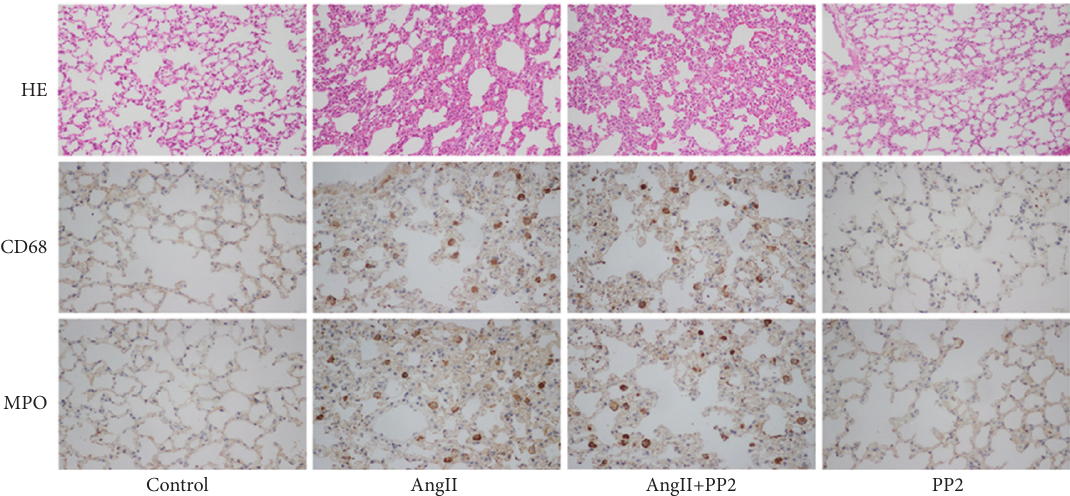
Figure 2: After establishing of acute lung injury model though minipumping of AngII, obvious edema was noticed in the pulmonary tissues in the AngII group, together with infiltration of neutrophils (MPO) and macrophages (CD68). However, after administration of PP2, no obvious changes were noticed in the infiltration of neutrophils and macrophages, as well as pulmonary edema compared with the AngII group. HE staining and immunohistochemistry images were observed under a magnification of 200x and 400x,